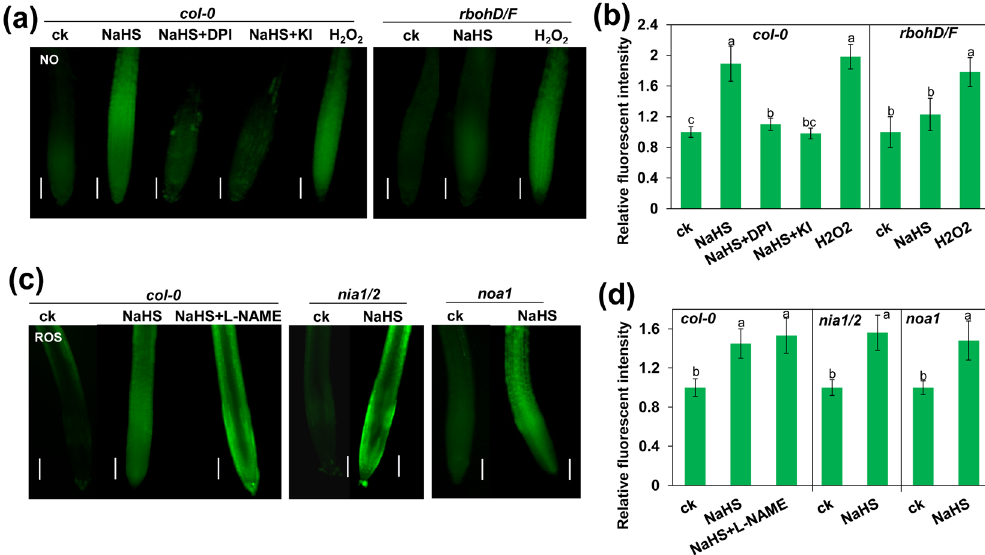
Figure 4. ( a , b ) Detection of NO production in the roots of 5-d-old wild-type Col - 0 and rbohD / F seedlings exposed to 500 μ M NaHS with or without 1 μ M DPI, 1 mM KI, and 1 mM H 2 O 2 for 24 h using the NO-specific fluorescent probe DAF-2 DA ( a ) and quantification of NO-specific fluorescence intensities ( b ) in plants treated as described in ( a ). ( c , d ) Detection of H 2 O 2 production in the roots of 5-d-old wild-type Col - 0 , nia1 / 2 , and noa1 seedlings exposed to 500 μ M NaHS with or without 500 μ M L-NAME for 24 h using the ROS-specific fluorescent probe DCFH-DA ( c ) and quantification of H 2 O 2 -specific fluorescence intensities ( d ) in plants treated as described in ( c ). The fluorescence intensity of the untreated roots was set to 100. Bars, 100 μ m. n = 30. ck, untreated control. Error bars represent ± SD.